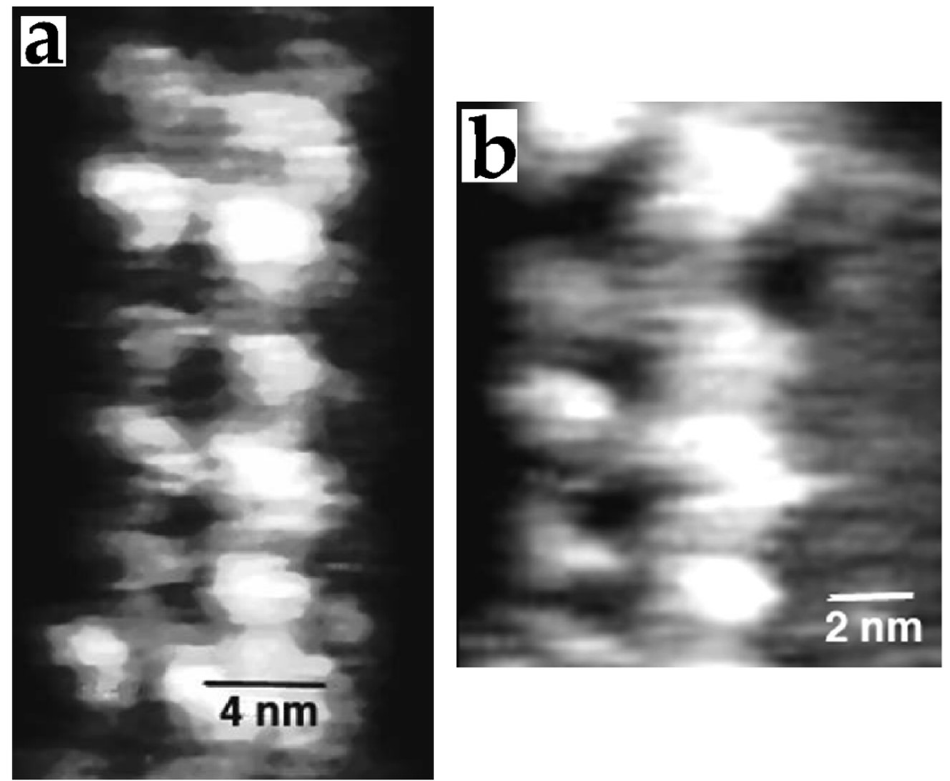
Figure 6. STM images of unfixed microtubules deposited on ITO surface. Typical images of micro- tubules ( a , b ). The images represent a portion of a microtubule, in which the arrangement of the tubulin proteins is slightly revealed. Reprinted with permission from Ref. [12]. Copyright (1994), The Company of